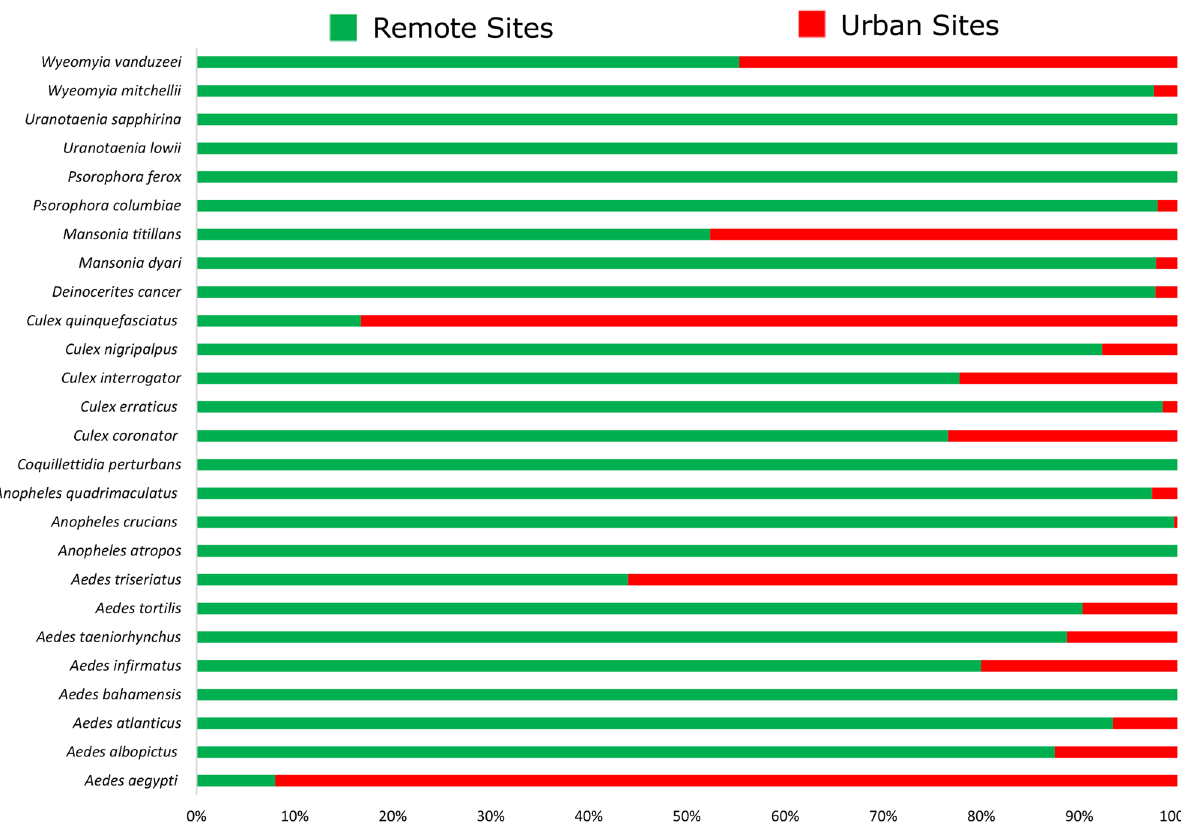
Figure 1. Relative proportion of mosquitoes collected at the remote and urban collection sites in Miami-Dade County,